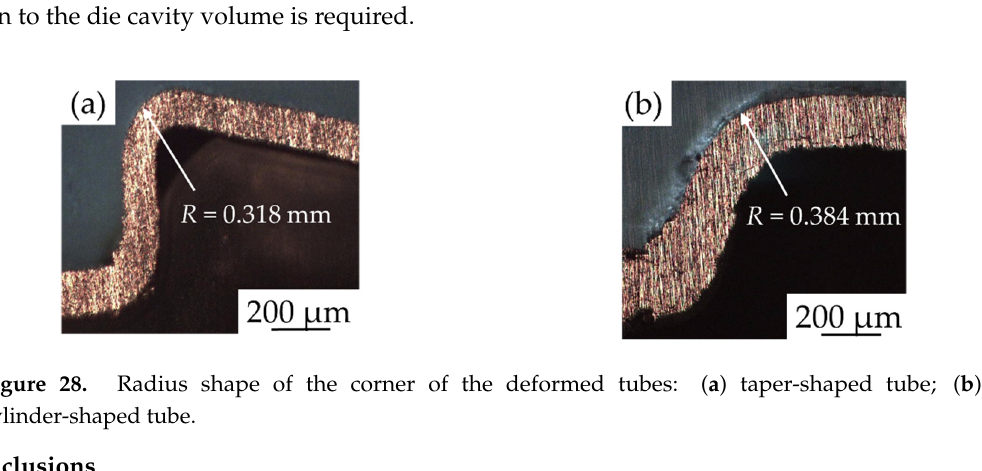
Figure 27. Microstructure of the wrinkled tube obtained from the cylinder-shape warm THF in Stage